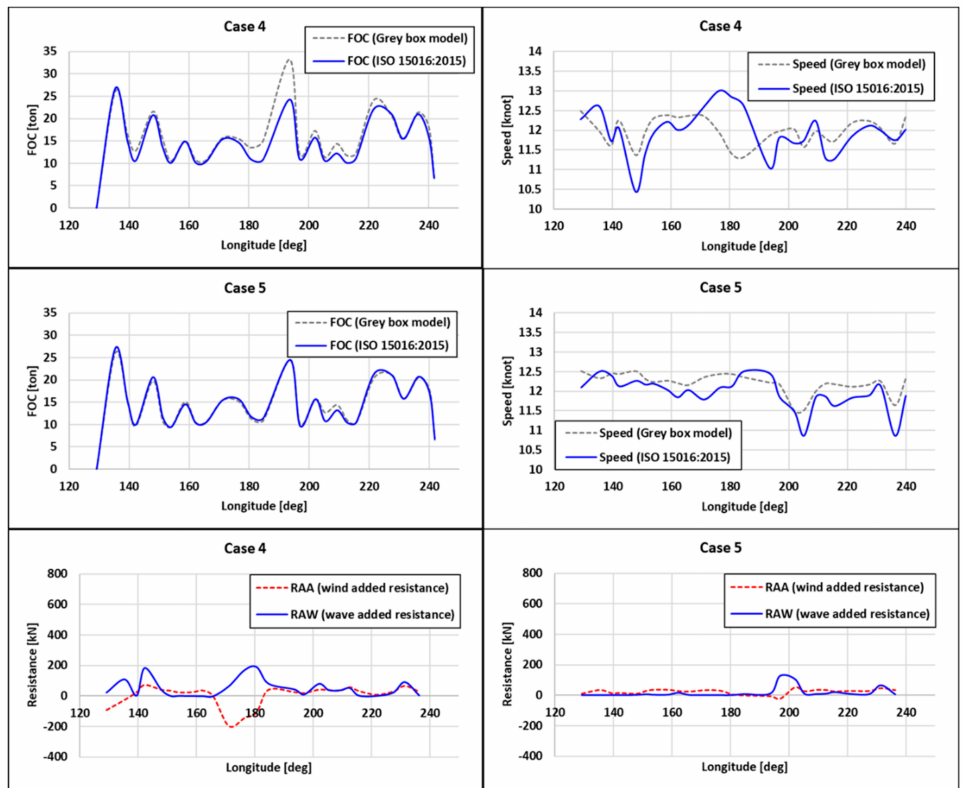
Figure 12. FOC, speed, and additional resistance graphs of Cases 4 and 5.